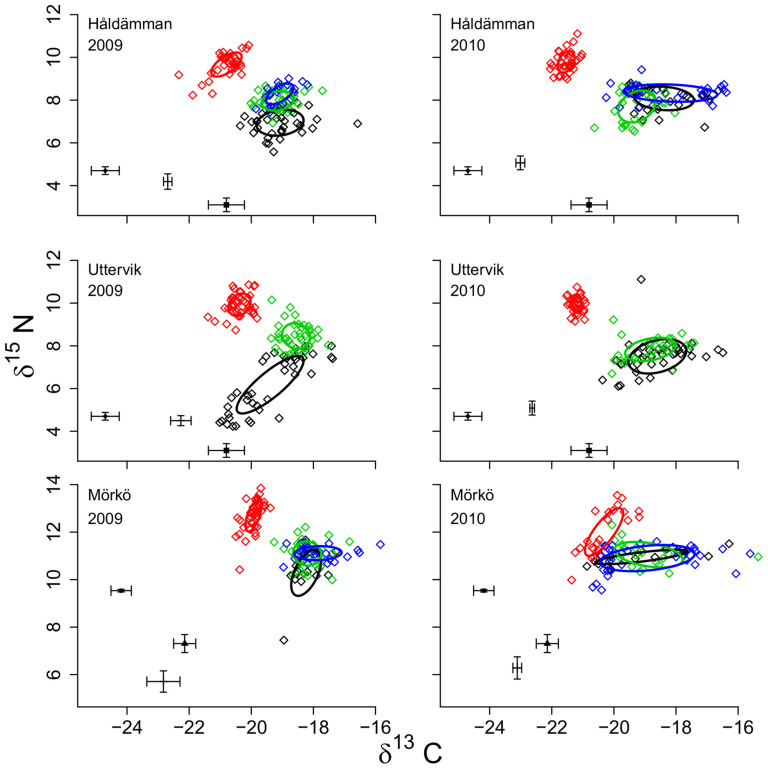
Stable isotope bi-plots illustrating the isotopic niche of the deposit-feeding community at the sampling stations.The invader Marenzelleria arctia (red) and the native co-occurring species, Monoporeia affinis (black), Macoma balthica (green), and Pontoporeia femorata (blue) at three stations in 2009 and 2010. All sampling events are pooled within years. The lines enclose the standard ellipse area (SEAc). Overlap between species is reported in Table 1. Sediment isotope value is denoted +, early spring bloom isotope value is denoted ♦ and late spring bloom isotope value is denoted ▪. Seston (stn Mörkö only) is denoted ▴. Resource data are mean ± standard deviation.